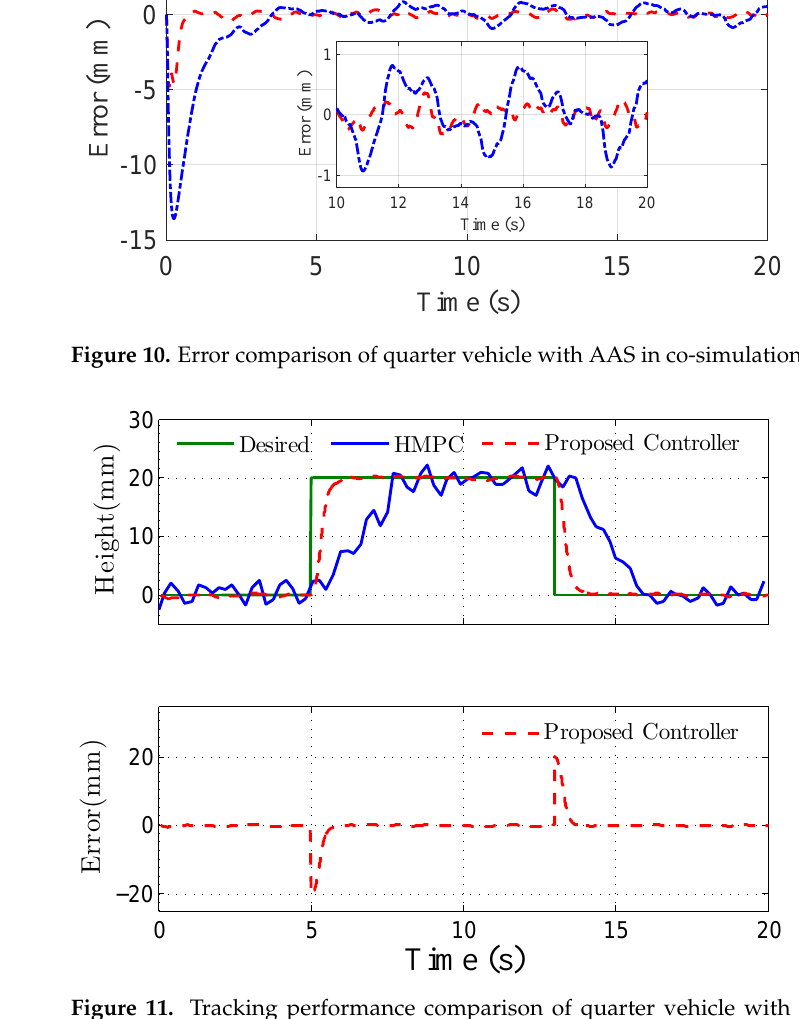
Figure 11. Tracking performance comparison of quarter vehicle with hybrid model predictive controller (HMPC) presented in [7]. Table 3. Performance index comparison of co-simulation.